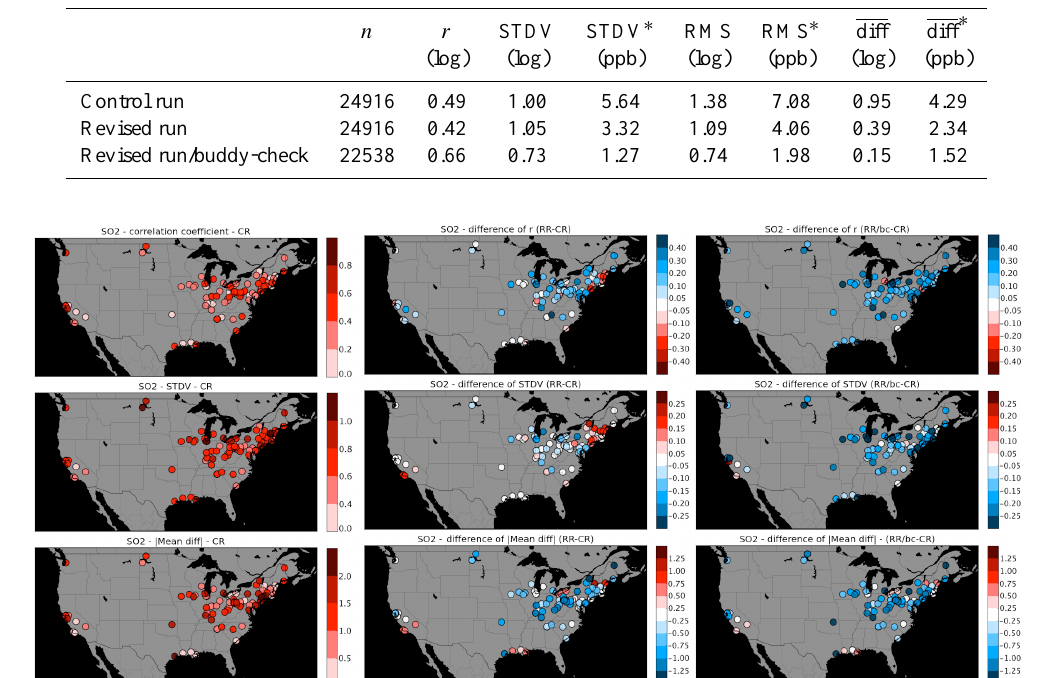
Fig. 5. The first column is r , the STDV and the absolute value of the mean difference between the modeled (control run) and observed daily averaged SO 2 surface concentrations for each SO 2 EPA site in 2010. The second column is the change in r , STDV, and absolute value of the mean difference for the revised run relative to the control run. The third column is the same, but showing the difference between the revised run (with buddy check of Dee et al. (2001)) and the control run. The color coding in the second and third column is such that blue indicates improvement relative to the control